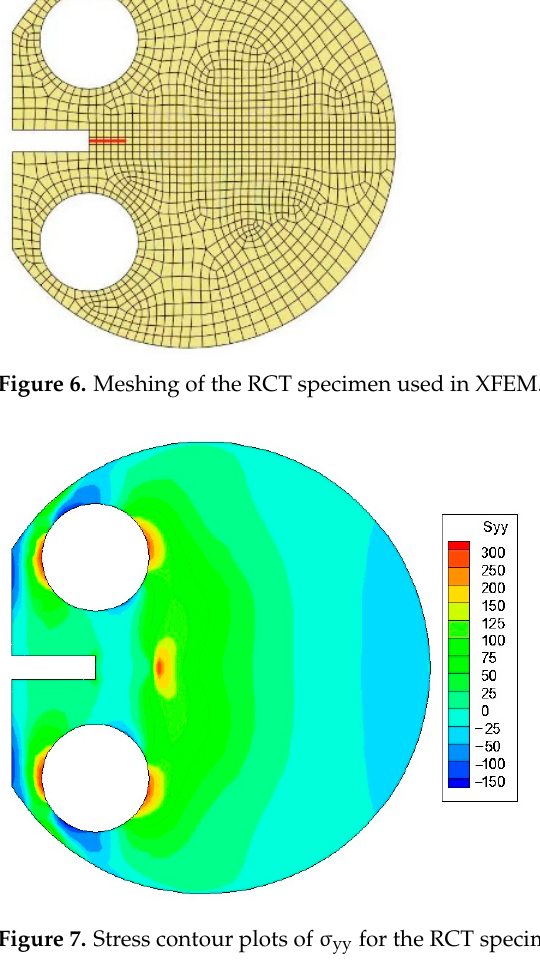
Figure 7. Stress contour plots of σ yy for the RCT specimen. (Unit: MPa).